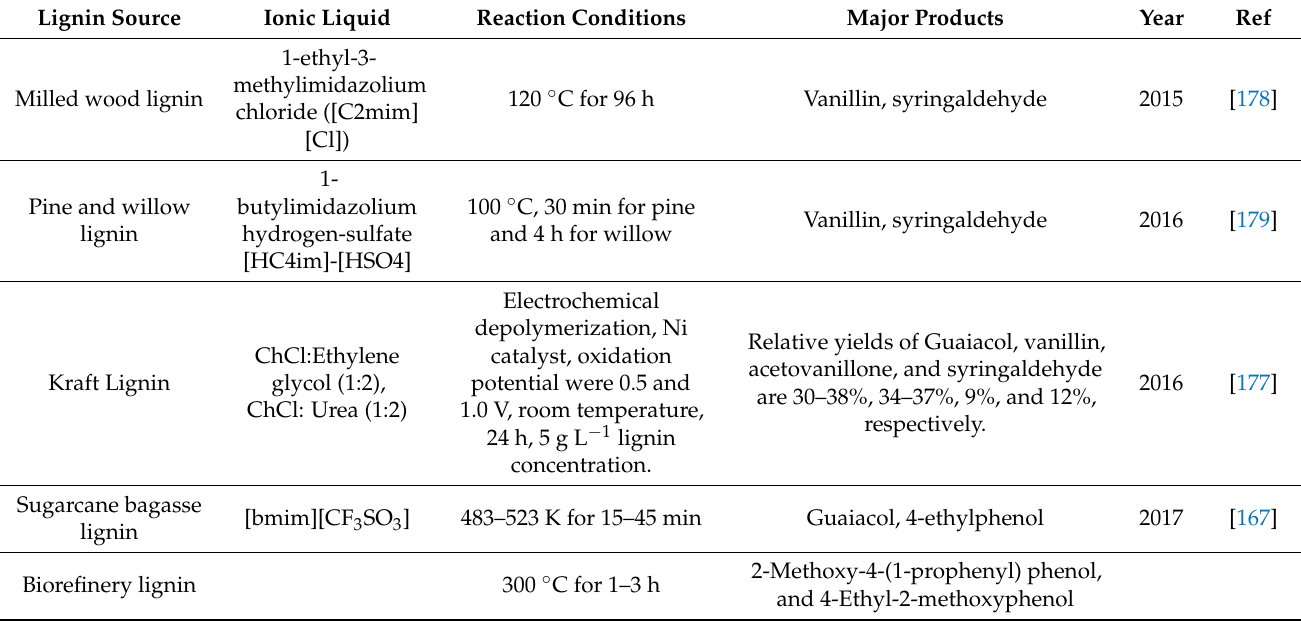
Table 8. Ionic liquid and deep eutectic solvent-based depolymerization of lignin.